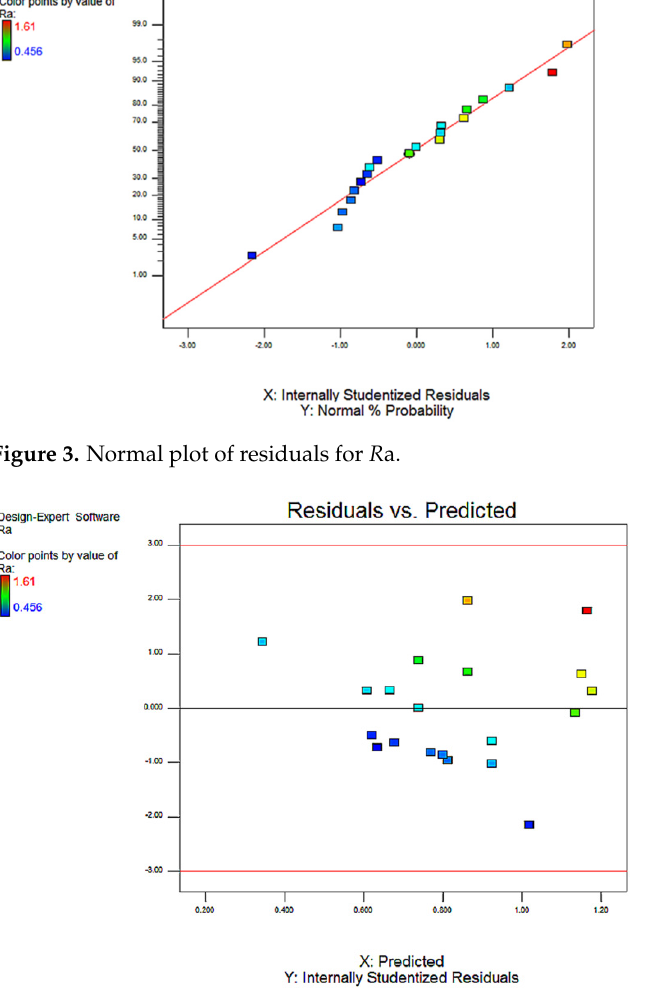
Figure 4. Plot of residuals vs. fitted values for R a.